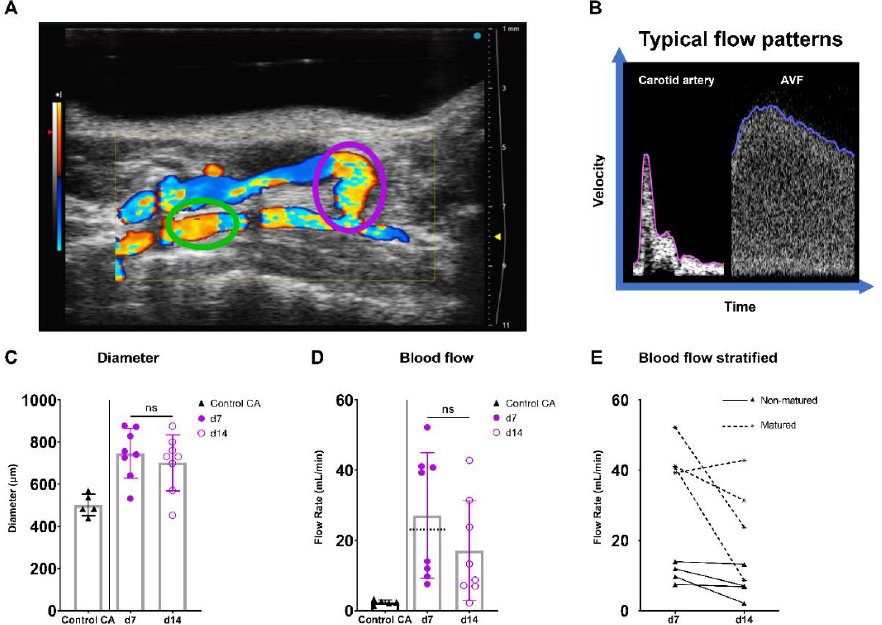
Figure 5. Diameter and blood flow rate measurements in AVFs in C57BL/6J mice over time. ( A ) Two-dimensional color Doppler recording of a murine AVF, with a pink oval indicating the location of anastomosis measurements and a green oval indicating the location of inflow artery measurements. ( B ) A typical velocity – time curve in a carotid artery (Control CA) and AVF in C57BL/6J mice. ( C ) Lumen diameter of control carotid arteries (n = 5) and murine AVFs (site of anastomosis) (n = 8) at 7 and 14 days after surgery. ( D ) Blood flow rate measurements of control carotid arteries (n = 5) and AVFs (n = 5) on 7 and 14 days after surgery. The dotted line indicates the cut-off value for fistula maturation (23 mL/min) ( E ) Blood flow rate measurements in the AVFs, stratified for AVF maturation or non-maturation at t = 7 days. Statistics AVF over time: paired t -test.